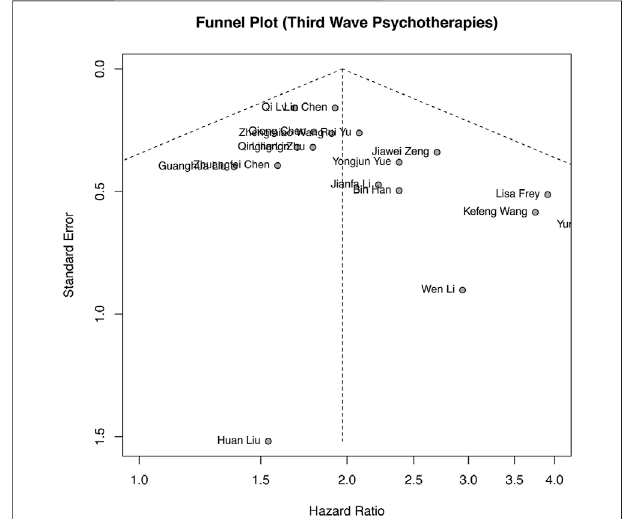
FIGURE 4 | Funnel plots of studies included in the